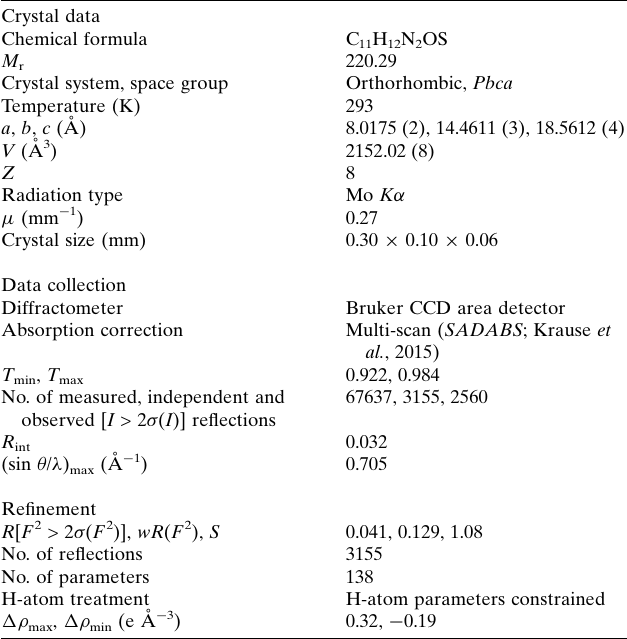
Table 2 Experimental